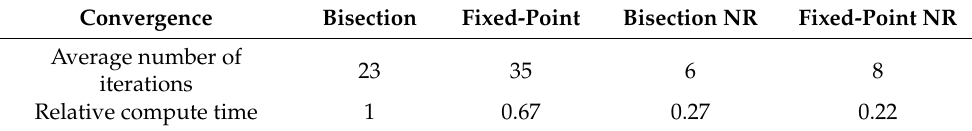
Figure 6 . Powered lift and wingless mass estimation and sizing error using ( a ) bisection, ( b ) fixed- point, ( c ) bisection NR hybrid, and ( d ) fixed-point NR hybrid methods. Table 4. Iterations and compute times using the bisection, fixed-point, and hybrid methods.